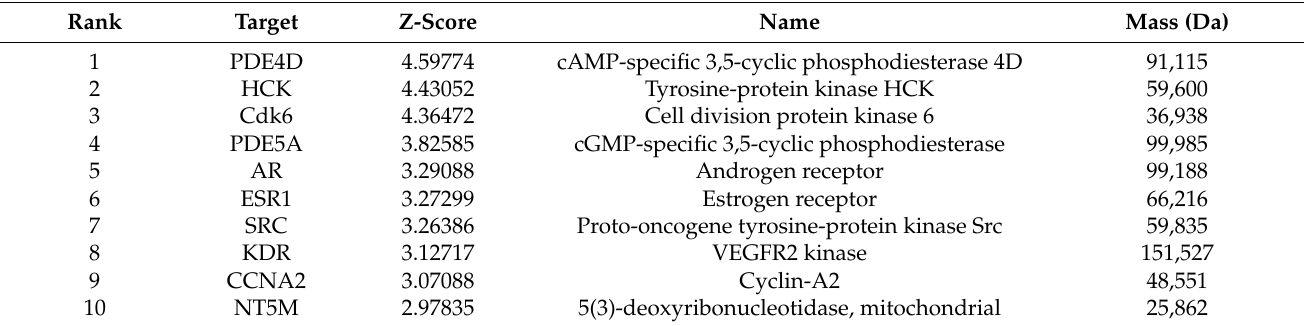
Figure 2. ( A ) The ranked list of hit targets of Kae from PharmMapper. ( B ) Target identification of Kae by TargetHunter using the 2D similarity compounds. ( C ) The DARTS assay was employed to detect the different bands, and a ~60 kD band increased upon Kae incubation. The red box indicated the detected bands at ~60 kD. Table 1. Top 10 target candidates of Kae identified by PharmMapper.